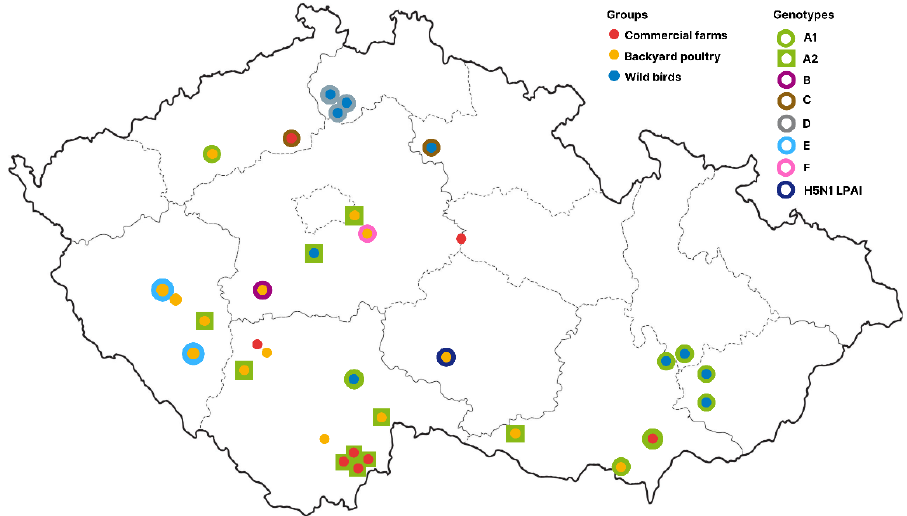
Figure 4. Geographical distribution of H5N1 genotypes. The figure shows the localities of H5N1 virus detections in the 2021/2022 season on a blind map of the Czech Republic. Solid dots indicate bird categories (wild, backyard, and commercial). Localities with available genotype information are surrounded by a halo indicating genotype assignment according to Figure 3. An interactive version of the map is available online at https://www.google.com/maps/d/u/0/edit?mid=1_pWrJqfuItU2UwgIuwHjJDsG-tugjU4q&usp=sharing (accessed on 20 November 2022).